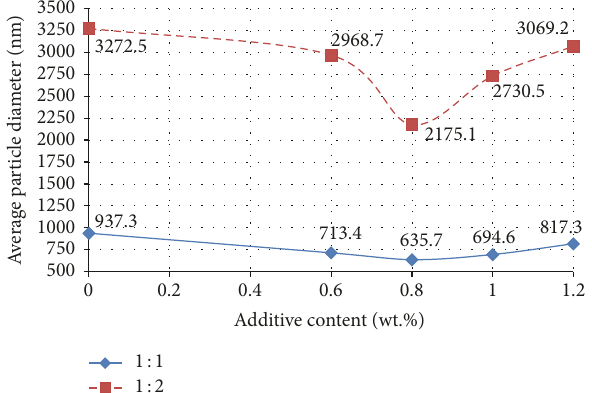
Figure7: Dependence of theaverage diameter ofdispersedparticles from the content of the additive in toluene: heptane medium.